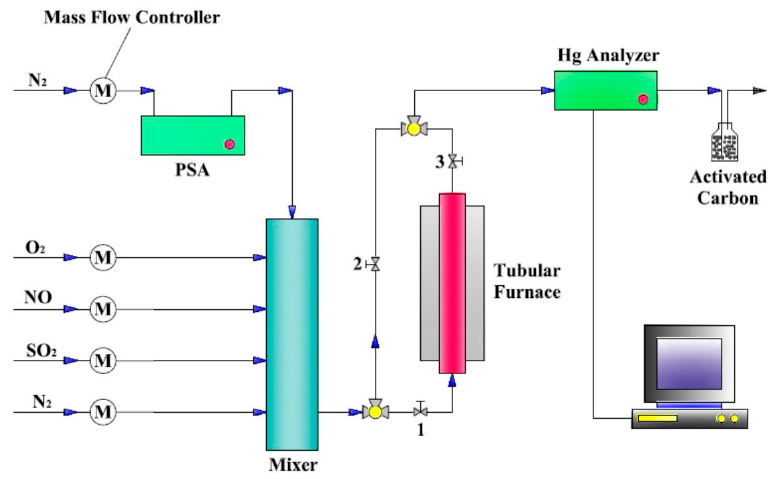
Figure 1. Schematic drawing of mercury removal experimental system.